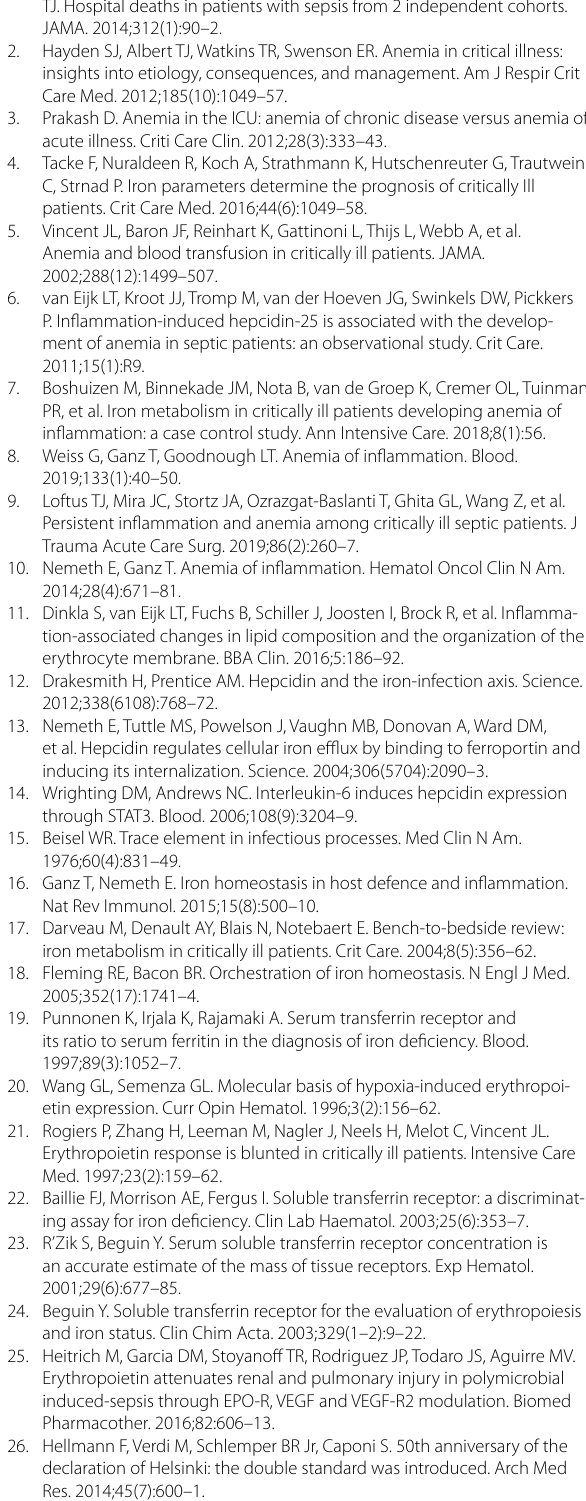
Additional file 1: Table S6. Correlation among inflammatory anemia‑ associated parameters and the SOFA